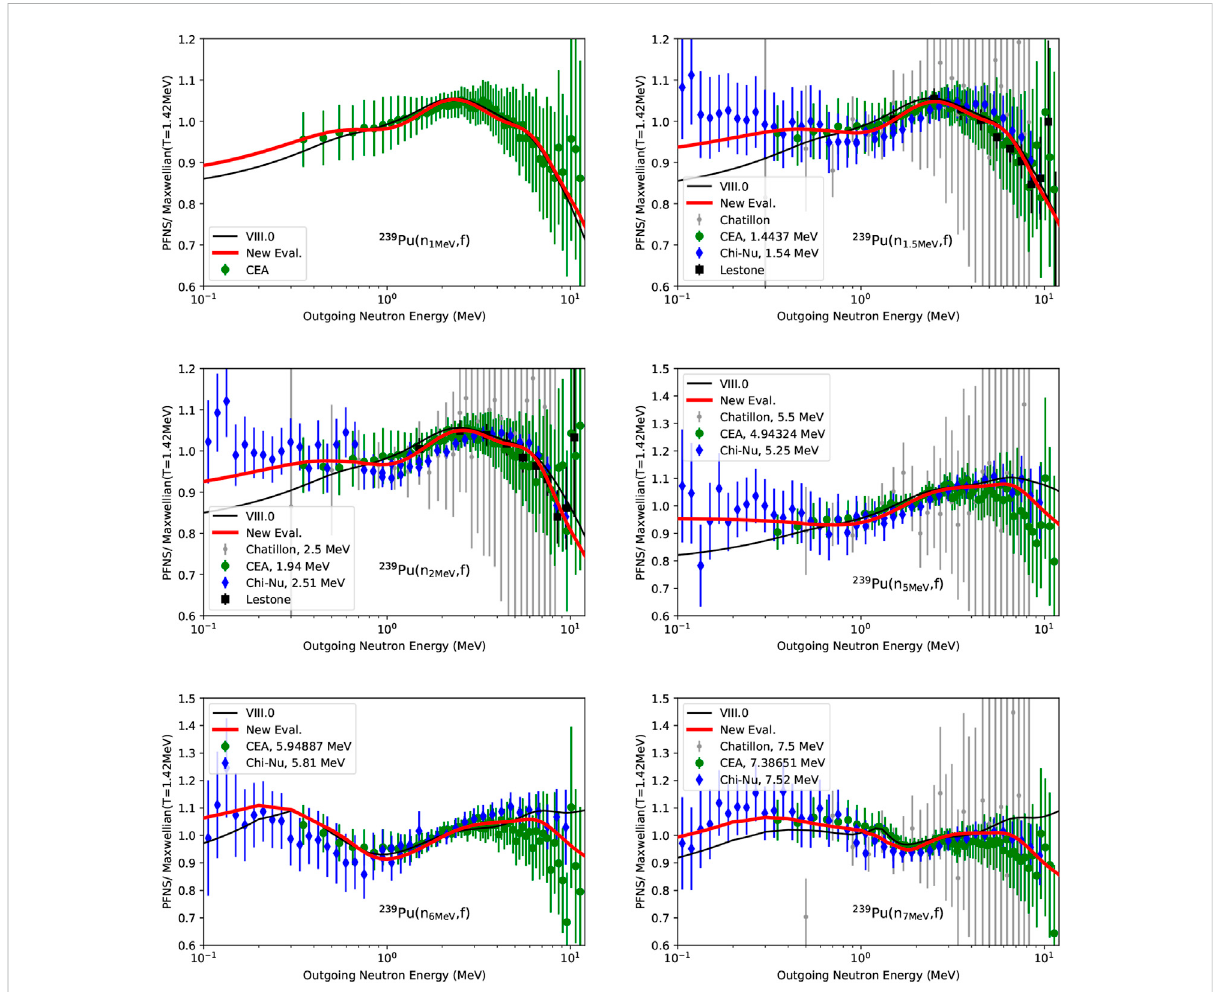
FIGURE 1 Evaluated 239 Pu PFNS are shown in comparison to ENDF/B-VIII.0 and experimental data that were used for the evaluation, for incident neutron energies from 1 to 7